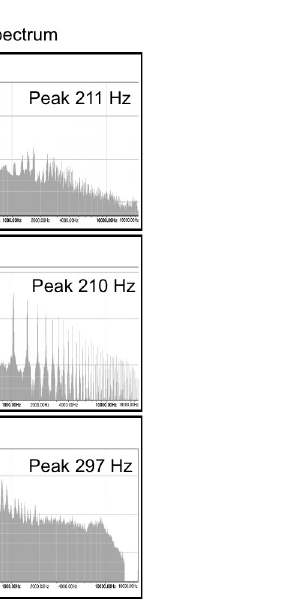
Fig 2. Frequency spectral densities and signal waveforms of the auditory